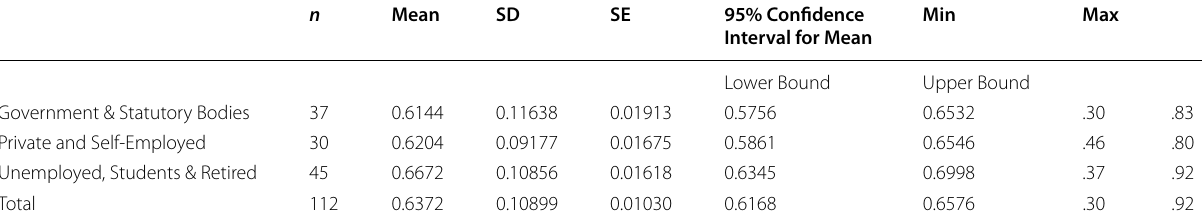
Levene’s test significant level is 0.730, and homogeneity of variances is assumed. F